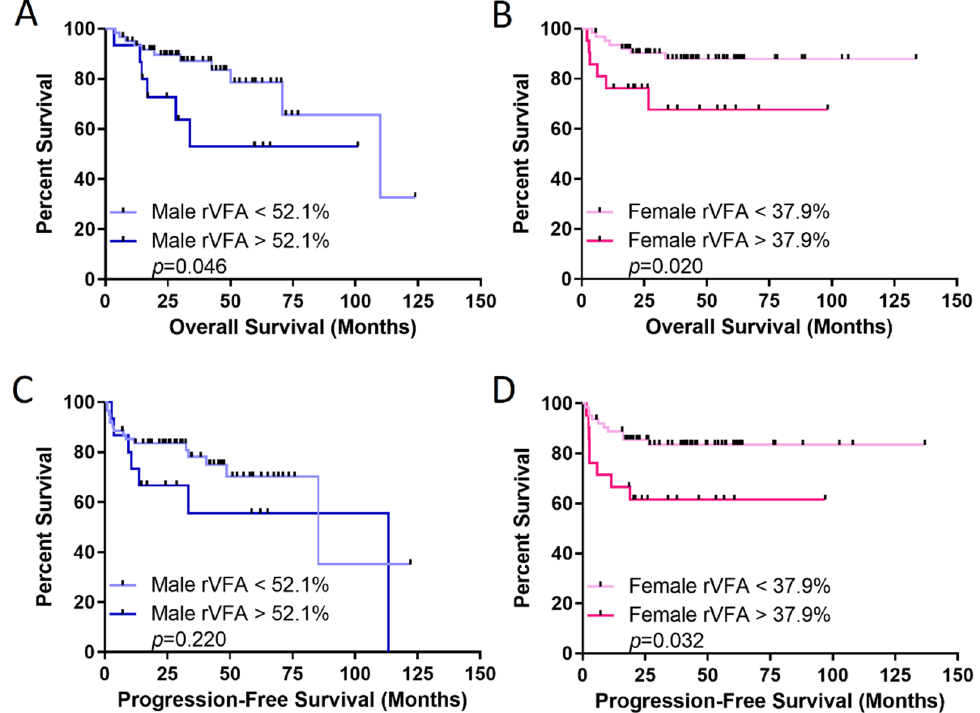
Figure 2. Relative visceral fat area (rVFA) is a better predictor of survival in females with DLBCL. Overall survival (OS) in ( A ) males and ( B ) females, and progression-free survival in ( C ) males and ( D ) females. rVFA thresholds identified with optimized biomarker threshold algorithm. p -value was calculated with the log-rank test. Table 3. Overall Survival (OS) multivariate Cox regression analysis for rVFA.